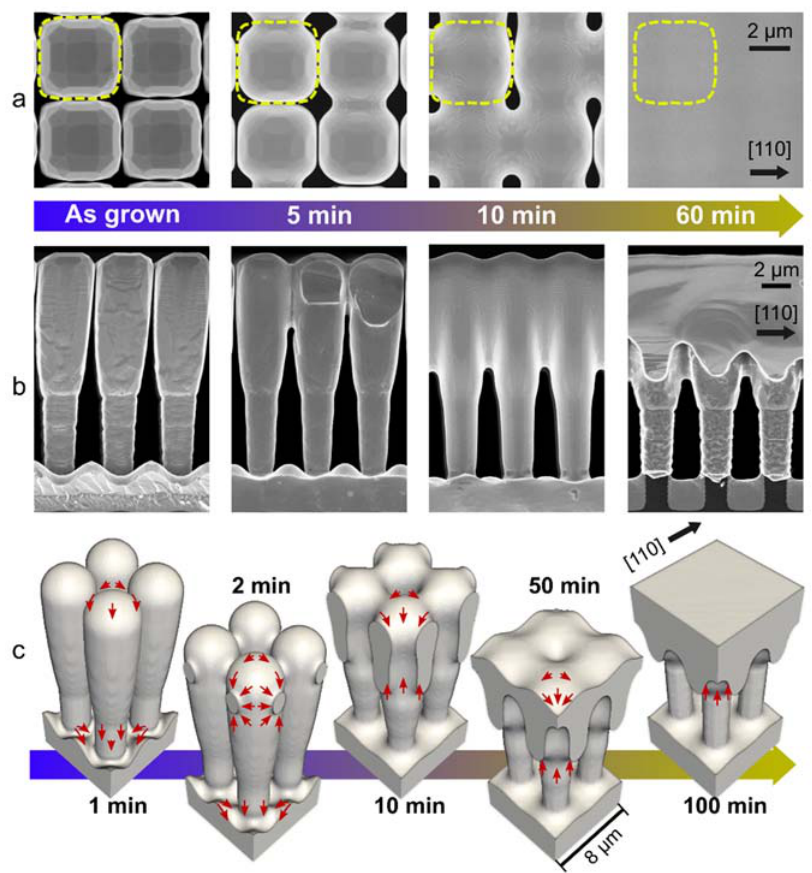
Figure 6. Coalescence of vertically-aligned Ge micro-crystals into a suspended film. ( a ) Top and ( b ) lateral SEM images of the as-grown crystals and of identical samples after annealing of different duration. ( c ) Evolution sequence obtained by a phase-field simulation of surface diffusion. First, local rounding of the facets occurs; then, connection bridges form between neighboring crystals leaving holes, that are finally filled by material flow. Reproduced with permission from [30]. American Chemical Society.